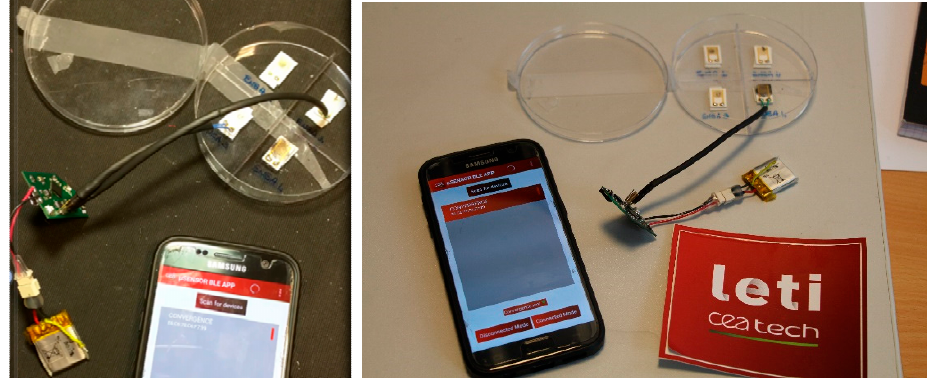
Figure 18. The graphene-based NO 2 sensors connected to the CEA-LETI platform.